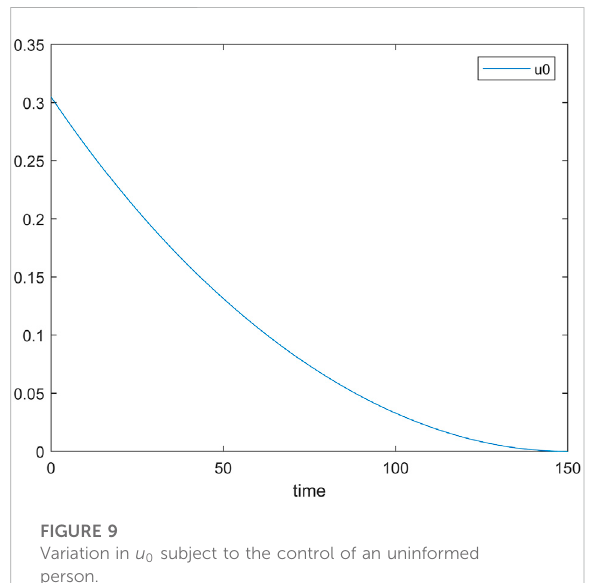
FIGURE 9 Variation in u 0 subject to the control of an uninformed